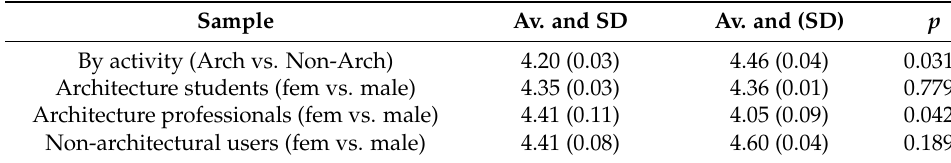
Table 4. T-test two-tailed (p) results of Q1–Q7 comparison, by activity. Sample Av. and SD By activity (Arch vs.